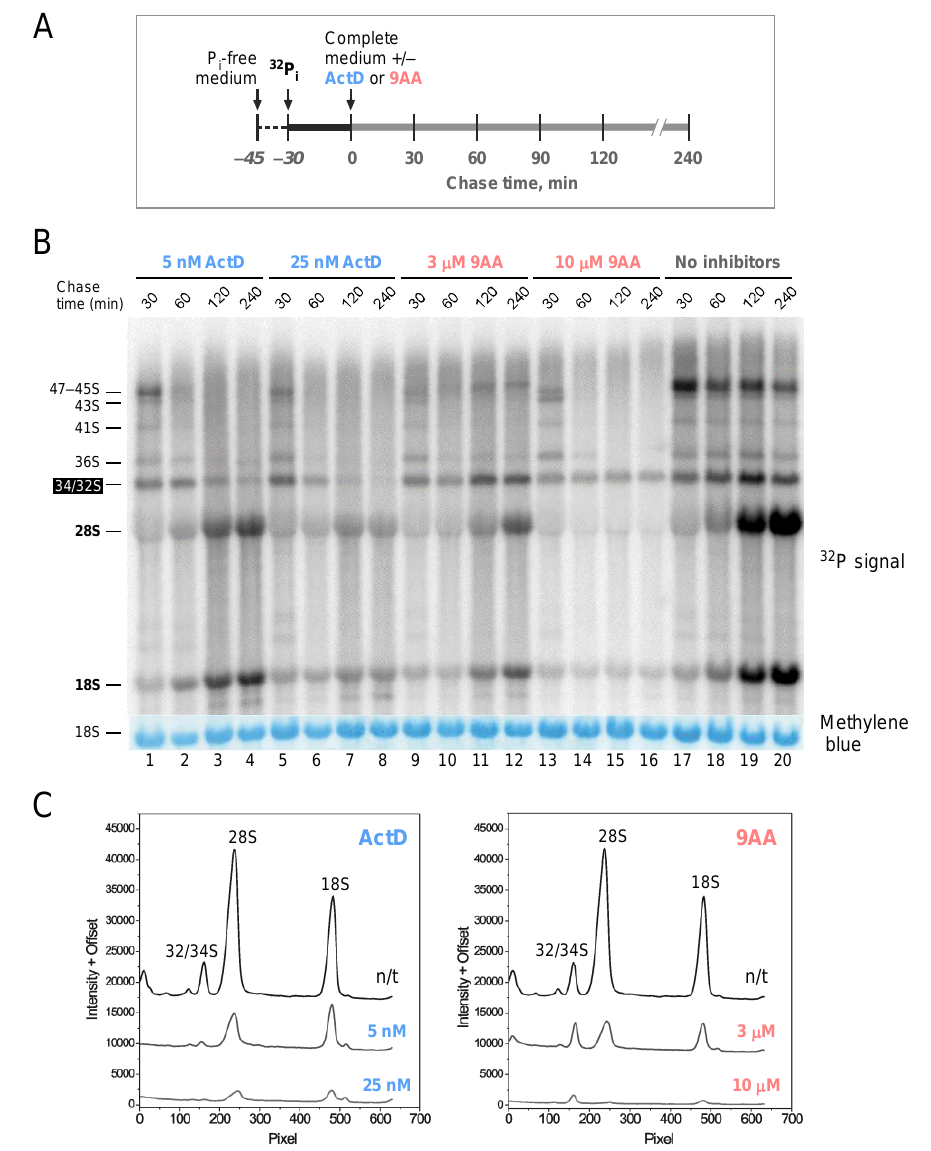
Figure 3. Metabolic labeling analysis of pre-rRNA maturation. ( A ) Cells were incubated in phosphate-free medium for 15 min, [ 32 P]-orthophosphate was added for 30 min, after which the labeling mix was removed, and the cells were incubated in complete growth medium with or without inhibitors for different times. ( B ) The isolated total cellular RNA was resolved on an agarose gel, transferred to a nylon membrane, and analyzed by phosphor imaging. At the bottom, 18S stained on the same membrane is shown to indicate loading. See Figure S1 for a diagram of mouse rRNA precursors. The highlighted 34S and 32S pre-rRNAs are further discussed in the text. ( C ) Radioactive traces of gel-separated RNA from cells that were treated for 240 min with the indicated concentrations of ActD and 9AA. Traces were obtained by phosphor imaging; pixel numbers indicate distance from the gel origin (each pixel unit is 0.1 µ